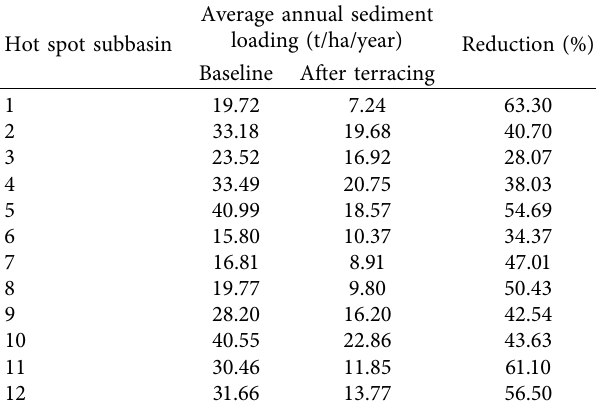
Table 16: Summary of sediment reduction with the simulation of terracing.